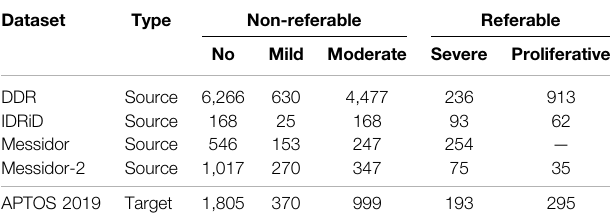
TABLE 1 | Label distributions of DDR, IDRiD, Messidor, Messidor-2, and APTOS 2019 datasets.